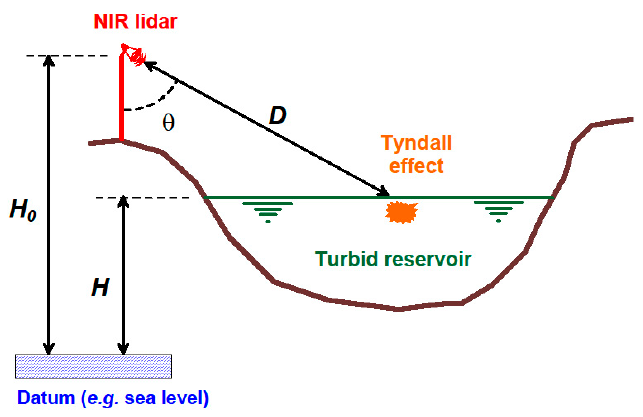
Figure 1. Sketch of the (sub-) surface water detection by an inclined Lidar pointing at a turbid water body.